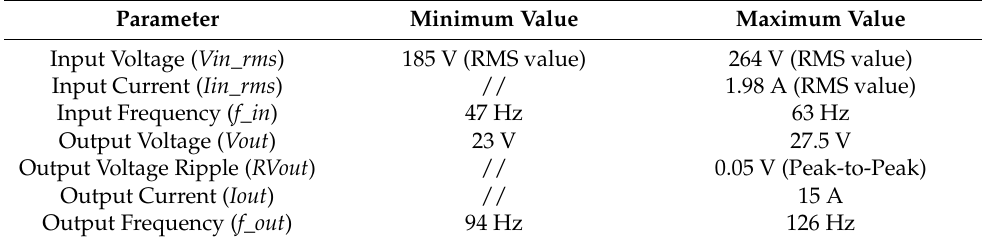
Table 1. Main nominal features of the considered AC/DC converter [1].